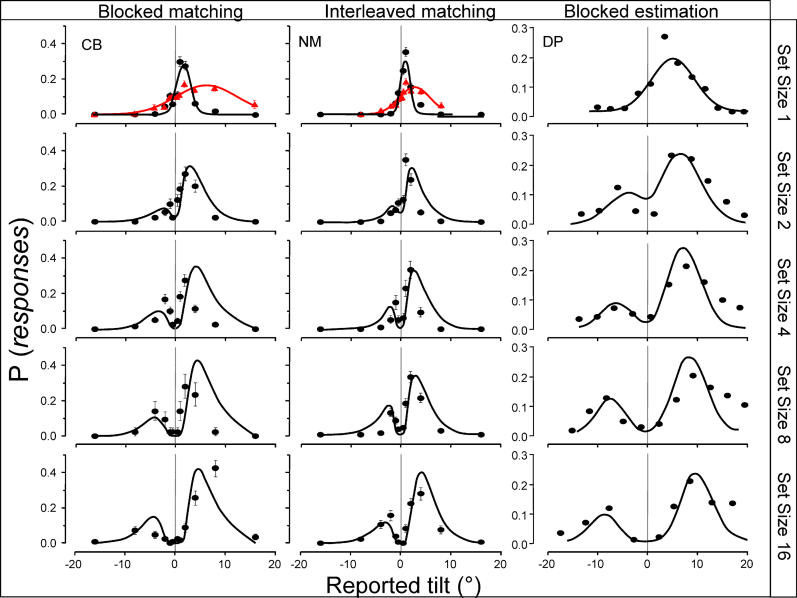
Response Distributions for Near-Threshold Stimuli for Three ObserversThree observers' response distributions are shown: CB (left graphs), author NM (middle graphs), and DP (right graphs). For CB and DP, the trials were blocked for set size within each session; for NM, they were randomly interleaved in each session (this had virtually no effect on results). The magnitude matching involved choosing from 12 target tilts; magnitude estimation involved rotating a continuous probe. Each row of plots refers to a particular set size. Each graph plots the proportion of responses to each response probe, collapsing clockwise with counterclockwise stimuli so correct responses become positive and incorrect responses become negative (binning the continuous-probe responses into one-octave logarithmically spaced bins). The positive portions of each distribution are about three-quarters of the total area, reflecting the 67%–83% definition of near-threshold performance. Red triangles in the set size 1 condition show results for orientation-perturbed stimuli, and black circles show normal unperturbed presentations. The error bars show an estimate of standard error of the mean computed by a bootstrap [30] procedure with 1,000 iterations. In the data of the graph at right, we estimated the standard error for both the reported tilt and the bin peak estimate, but they are both smaller than the data points. Note that in these graphs we have rescaled the ordinate as observer DP had lower orientation sensitivity, which caused widening and shortening of the distributions, but showed no difference in the their trend. All curves were tested for bimodality in the following way. The largest positive and negative responses were selected as potential peaks. If any data points between them were significantly lower than both these peaks (bootstrapt test,p < 0.01) then the distribution was classified as bimodal. All the curves of set size 1, except for CB no-noise, were classified as unimodal. All the curves of larger set size, except NM set size 2, were classified bimodal. The smooth lines show the results of simulation of the signed max model described in the text. It provides good fits to the data, both in predicting uni- and bimodality, and in predicting the separation of the peaks.